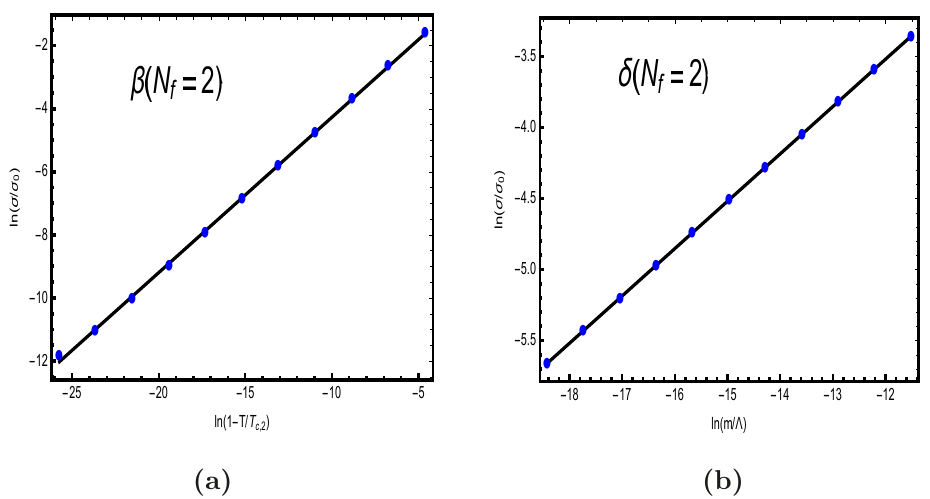
Figure 3 . Temperature and quark mass dependence of chiral condensate with two degenerate quarks near the critical point T c, 2 = 0 . 1515 . . . MeV , m c, 2 = 0 , σ c, 2 = 0. The corresponding dilaton profile are shown in eqs. ( 2.2)–(2.3) and the scalar potential parameters are taken as v 3 = 0 , v 4 = 8. Panel.(a) gives ln( σ ) as a function of ln( t ), with fixed quark mass m = m c, 2 = 0. The blue dots σ 0 are model calculation and the black solid straight line are linear fitting of the dots, which has the form y = 0 . 648+0 . 492 x . Panel.(b) gives ln( σ ) as a function of ln( m ), with Λ = 1 GeV a parameter Λ σ 0 introduced to make the quantity inside the logarithmic function dimensionless. The blue dots are model calculation and the black solid straight line are linear fitting of the dots, which has the form y = 0 . 480 + 0 . 333 x